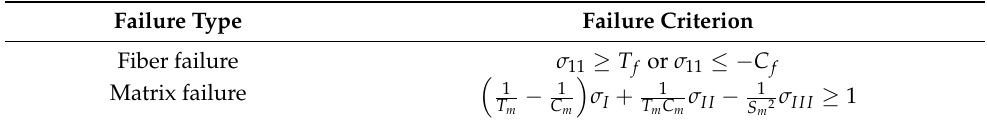
Table 1. The MMF3 criterion in determining micro-scale